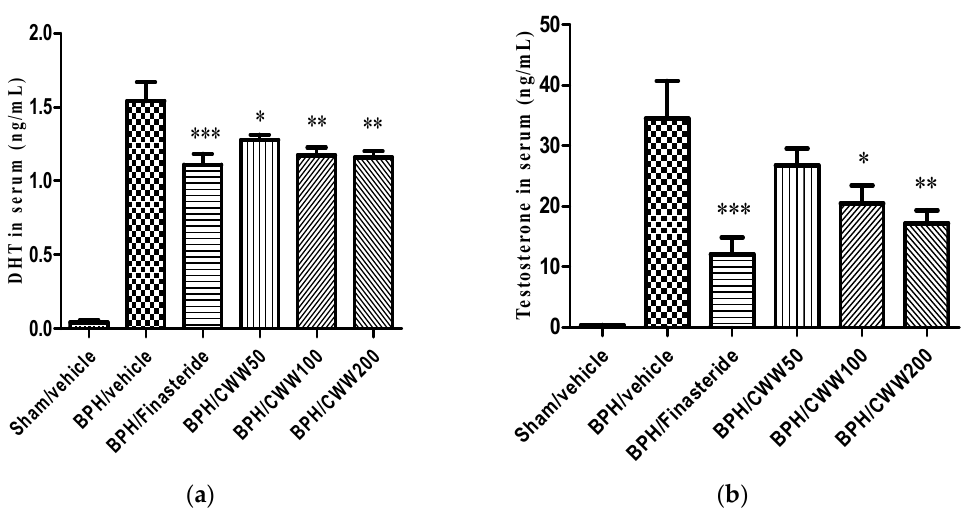
Figure 1. Effects of aqueous Cynanchum wilfordii extract (CWW) on serum ( a ) dihydrotestosterone (DHT) and ( b ) testosterone levels. *** p < 0.005, ** p < 0.01, and * p < 0.05 vs. the BPH/vehicle group. BPH: benign prostatic hyperplasia; Sham/vehicle: sham-operated and phosphate-buffered saline (PBS), oral (p.o.); BPH/vehicle: testosterone, subcutaneous (s.c.) and PBS, p.o.; BPH/finasteride: testosterone, s.c. and finasteride 5 mg/kg, p.o.; BPH/CWW 50: testosterone, s.c. and CWW 50 mg/kg,